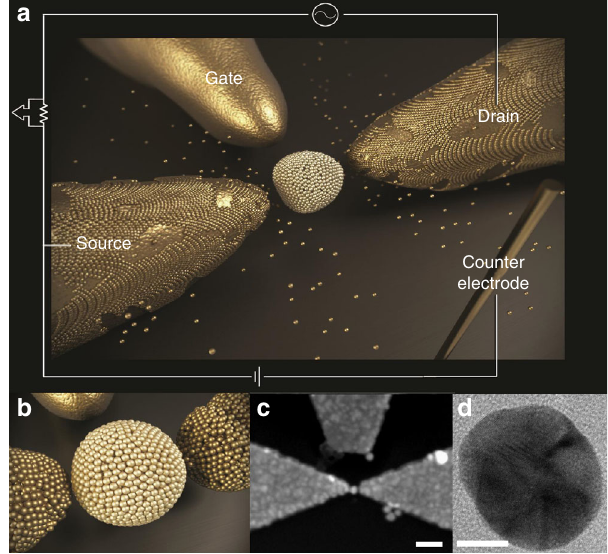
Fig. 1 The fabrication system. a An illustration of the nanoparticle and the arrangement of source, drain and gate electrodes. The device is immersed in the electrodeposition solution and gold atoms are grown on the source and drain electrodes thus closing the gap between them and the nanoparticle. b A closeup of the single-electron transistor demonstrating the expected con fi guration after the electrodeposition process in which the particle is coupled to the leads via a number of close atoms. c Scanning electron microscope image of a dot-leads system. The scale bar represents 100 nm. d Transmission electron microscope image of a gold colloid. The scale bar represents 10